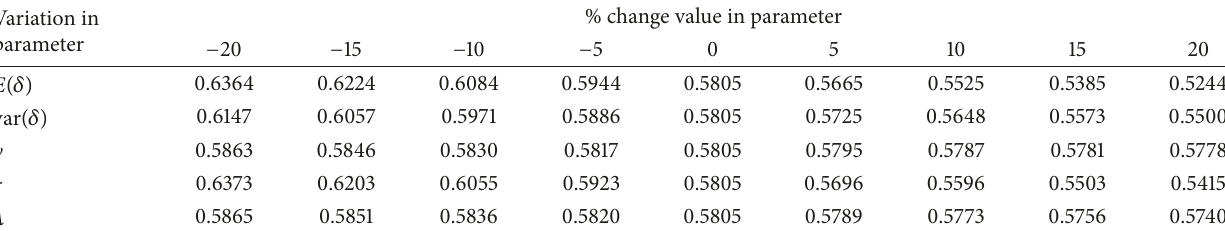
Table 3: Effects of changing four categories of parameters on 𝑄 𝐺